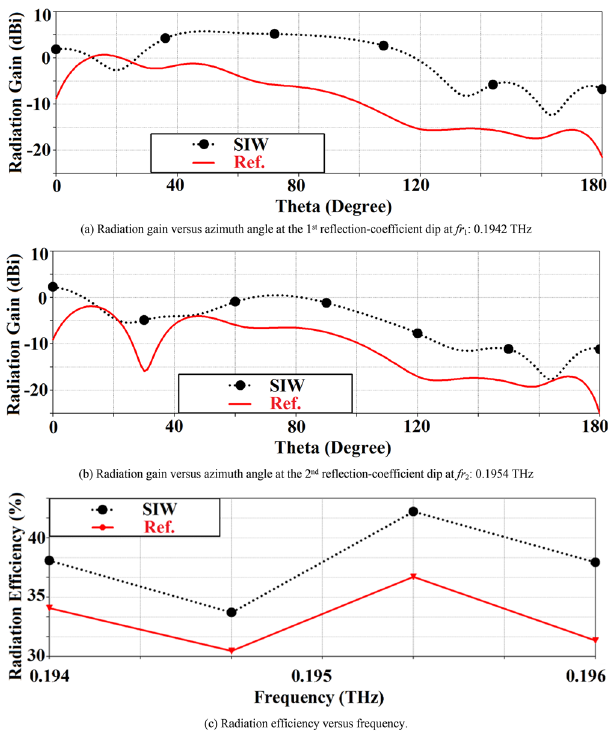
Figure 5. Simulated radiation gain and efficiency plots of the reference and SIW-loaded